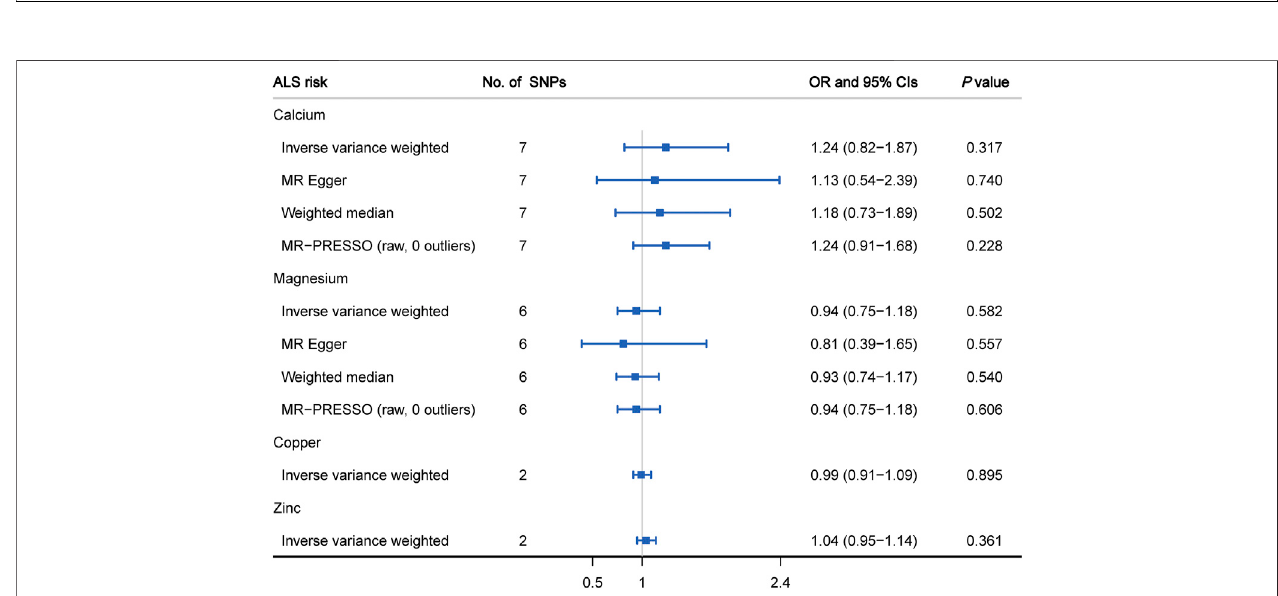
FIGURE 2 | MR analysis of genetically predicted levels of circulating vitamins and ALS risk.